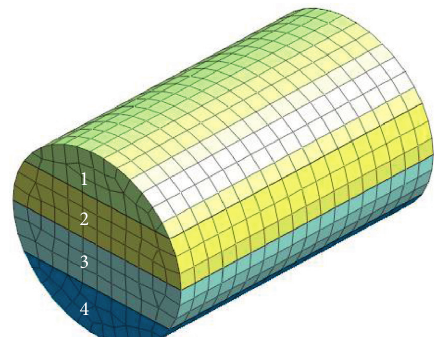
Figure 6: Tunnel model (4-step method).